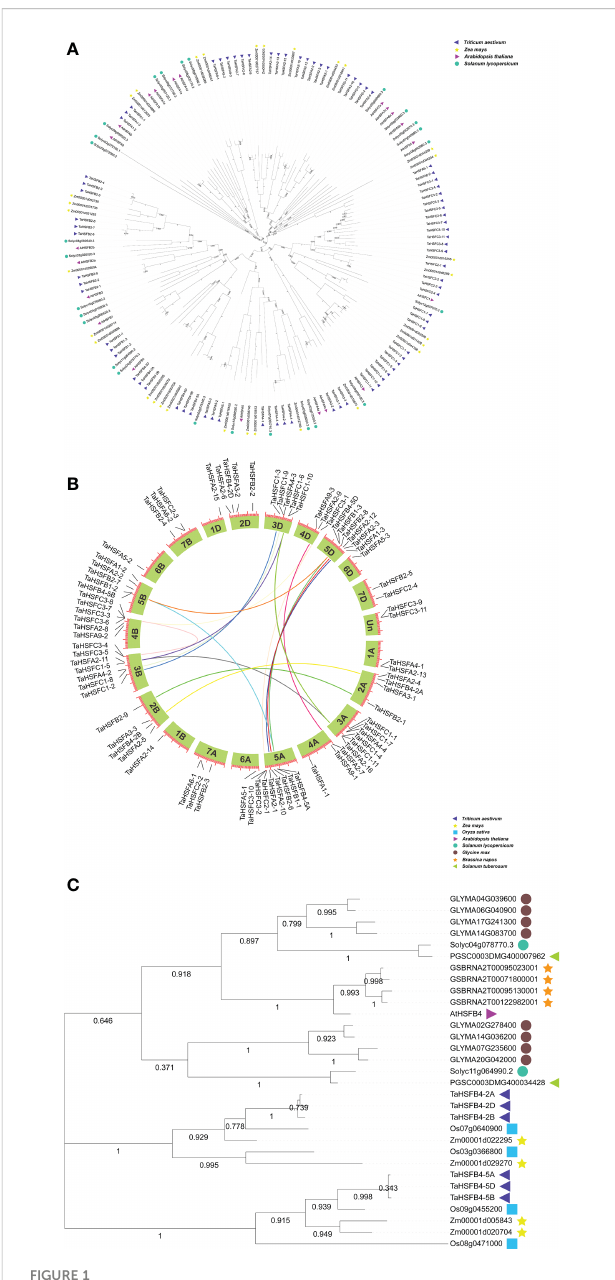
FIGURE 1 Neighbor-joining phylogenetic tree and synteny analysis of TaHSF families. (A) Neighbor-joining phylogenetic tree of Triticum aestivum ( Ta ), Arabidopsis thaliana ( At ), Zea mays ( Zm ) and Solanum lycopersicum ( Sl ) HSF families. TaHSFB4-2A, TaHSFB4-2B, and TaHSFB4-2D were marked in red. (B) Synteny analysis of TaHSF genes. (C) Phylogenetic analysis and amino acid sequence alignment of HSFB4s in Ta , At , Zm , Sl , Oryza sativa ( Os ), Glycine max ( Gm ), Solanum tuberosum ( St ) and Brassica napus ( Bn